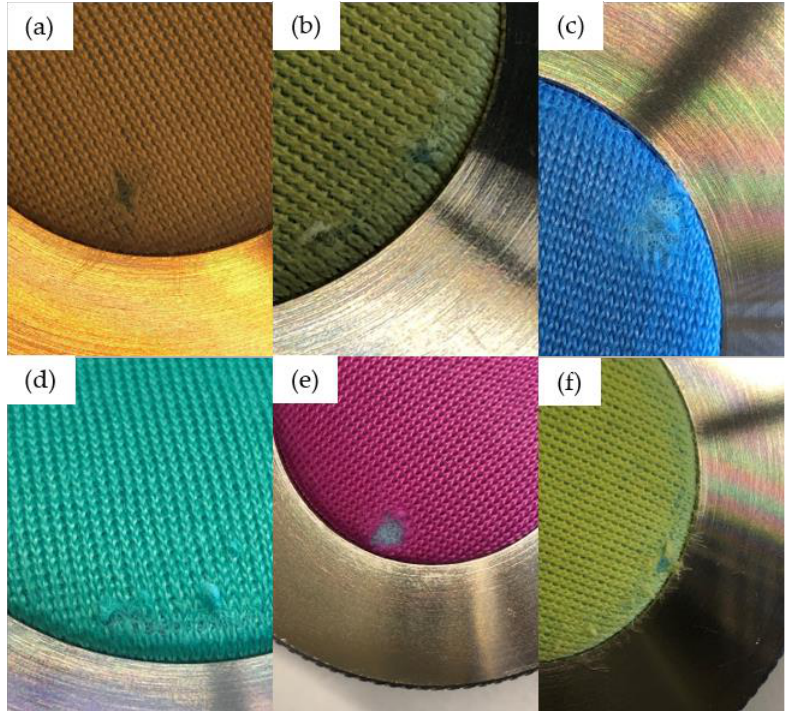
Figure 12. First signs of abrasion in knitted PLA fabrics: ( a ) PLA.1, ( b ) A03.1, ( c ) B03.1, ( d ) G03.1, ( e ) P03.1, and ( f ) Y03.1. Table 8. Abrasion resistance and color fastness of PLA and dyed fabrics containing 0.3% ( w / w ) of each colorant, determined using the Martindale abrasion test.